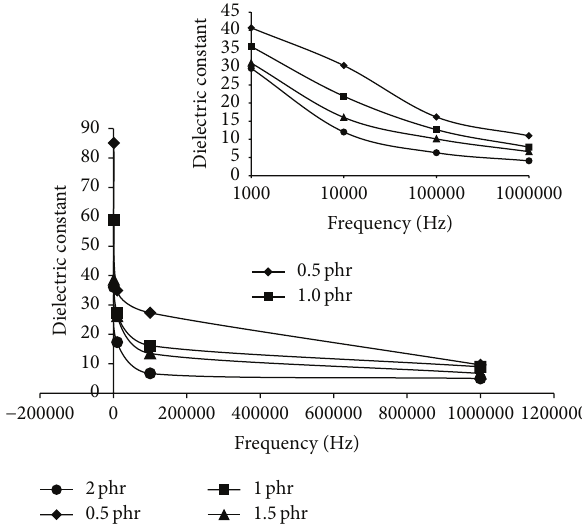
Figure 6: The dielectric constant of porous epoxy for epoxy, latex, and hardener (ELH) mixing by ultrasonic technique.